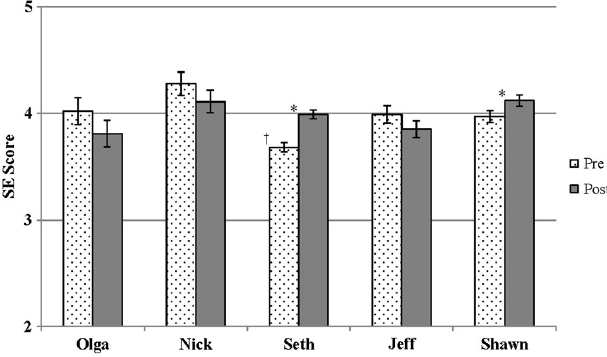
FIG. 2. Mean SE scores by instructor. *Seth ’ s and Shawn ’ s posttest scores were significantly higher than their pretest scores ( p ≤ 0 . 001 ). † Seth ’ s pretest score was significant lower than all other instructors ’ (all p < 0 . 01 ), except Olga ’ s ( p ¼ 0 . 13 ). Bars show standard